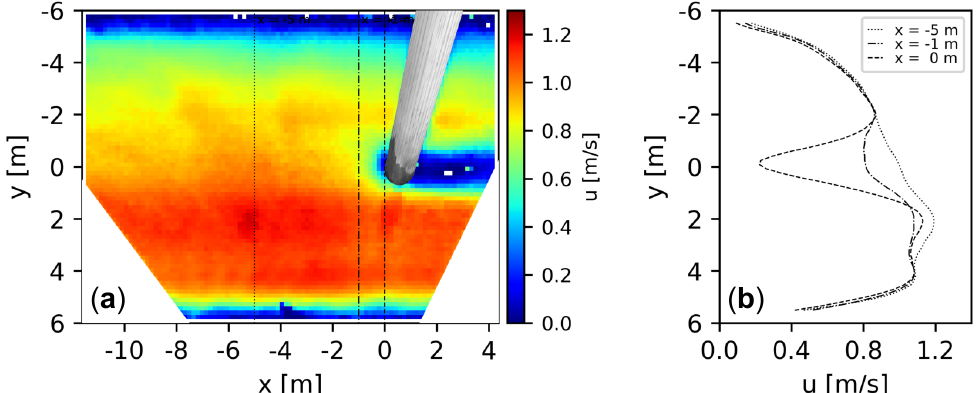
Figure 3. ( a ) Streamwise surface velocity u at the test site. Note that u is generally higher towards the right bank than towards the left bank due to the slight left bend of the River Glatt. Vertical lines illustrate location of lateral profiles. ( b ) Lateral profiles of u at distances of x = − 5m, x = − 3m and x = 0m from the upper edge of the